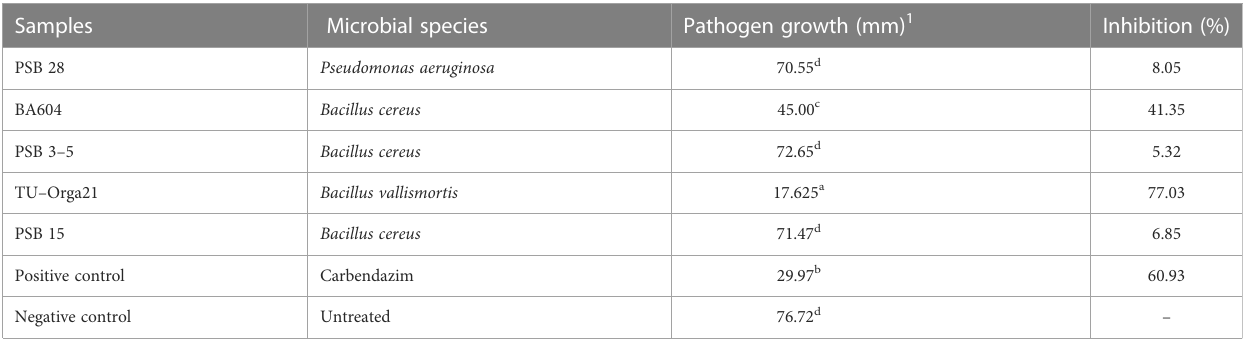
TABLE 2 Antagonistic activity of Bacillus sp. and Pseudomonas sp. against Magnaporthe oryzae causing rice blast, as assessed using the dual culture method. Samples